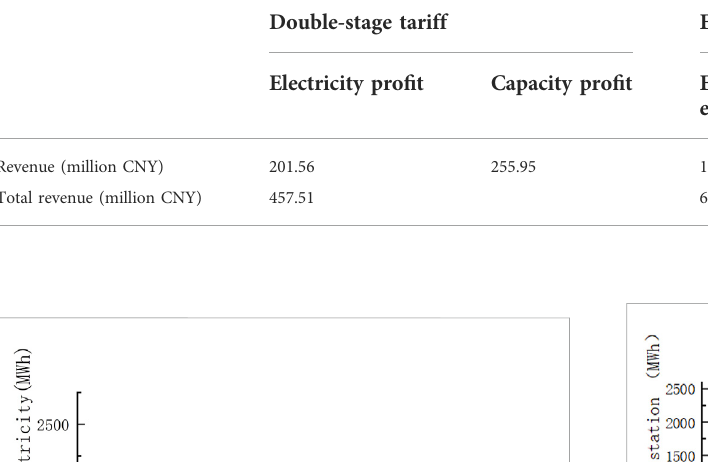
TABLE 5 Pro fi t of PSPP under different electricity tariff schemes.